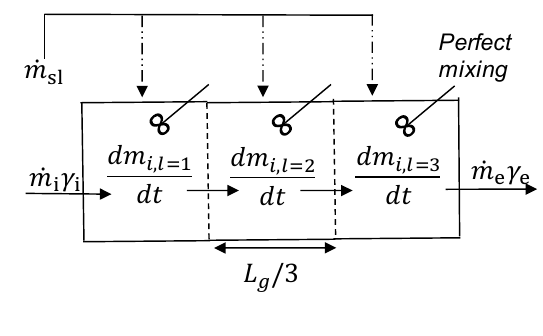
Figure 2: Multi-compartment rotary drum